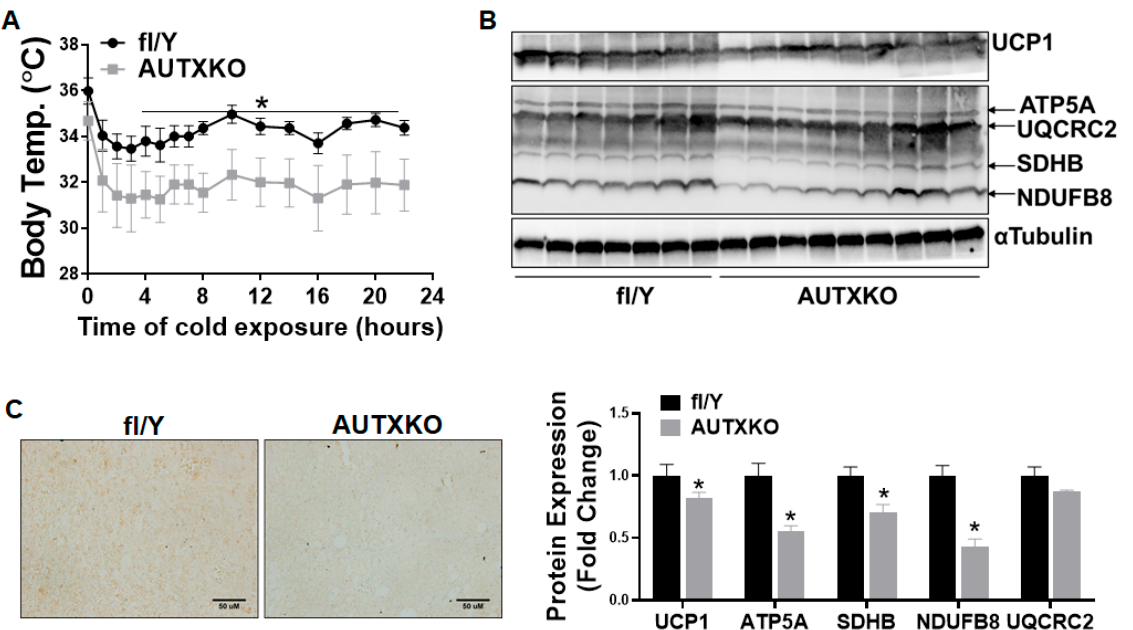
Figure 4. Utx deficiency in adipocytes reduces brown fat thermogenesis in cold-challenged animals. Male AUTXKO and fl/Y animals at 5 months of age underwent a 7-day cold challenge at 5 °C. ( A ) Body temperature of male AUTXKO and fl/Y animals. ( B ) Western blots of UCP1 and mitochondrial electron transport chain proteins in the brown fat of male AUTXKO and fl/Y animals with blot images on top the panel and quantitation of blot densitometry on the bottom panel. ( C ) Immuno- histochemical (IHC) staining of UCP1 in the brown fat of male AUTXKO and fl/Y animals. All data are presented as mean ± S.E.M.; n = 7–9/group; * p < 0.05 vs. fl/Y .